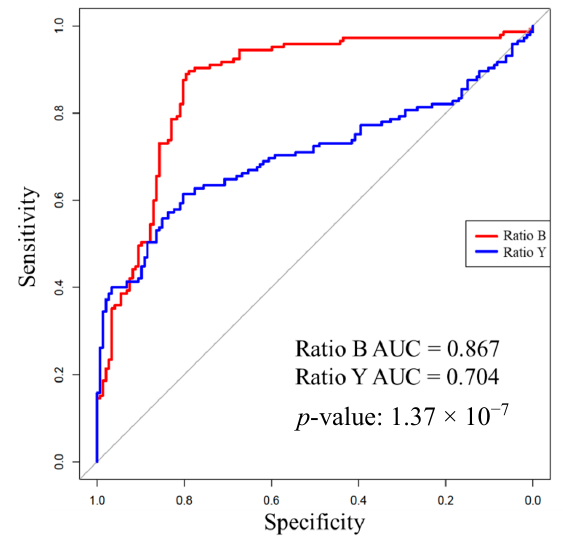
Figure 5. Receiver operator characteristic curves including all Ratio B and Ratio Y measurements in this study with corresponding area under the curve (AUC) values. The AUC for Ratio B is statistically significantly greater than for Ratio Y. In this context, specificity and sensitivity are reported according to correct identification of trachea.